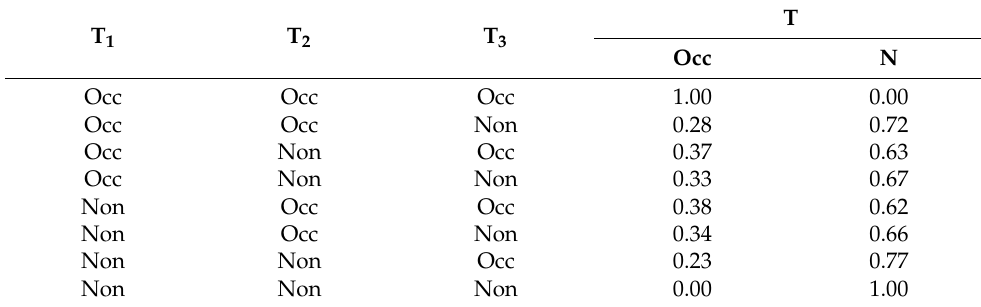
Table A12. The CPT of event T (Gasifier failure; Occ: occurred; Non: